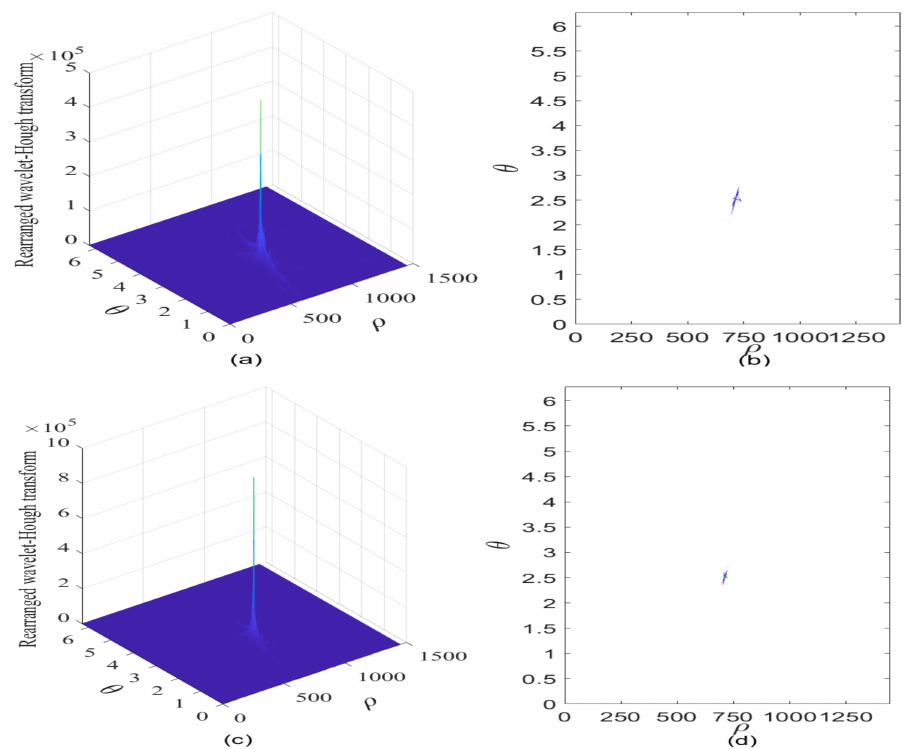
Figure 12. The rearranged Wavelet–Hough transform of the GPS L1-C/A signal in the presence of sweep interference. C / N 0 = 40 dB-Hz. ( a ) Rearranged Wavelet–Hough transform, JNR = − 8 dB; ( b ) Contour of rearranged Wavelet–Hough transform; ( c ) Rearranged Wavelet–Hough transform, JNR = − 2 dB; ( d ) Contour of rearranged Wavelet–Hough